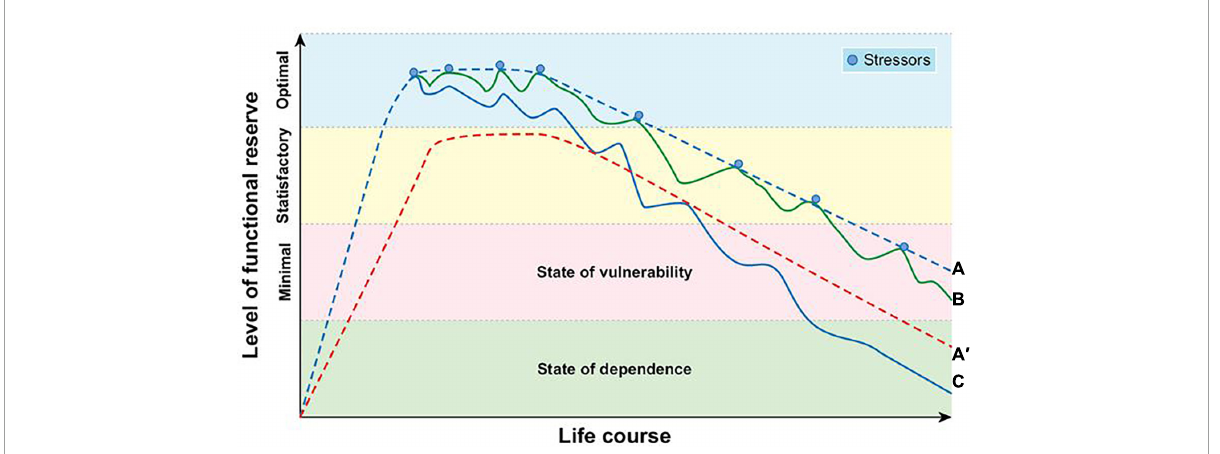
FIGURE1 Schematic representation of life-course trajectories of functional reserve and vulnerability to stressors. (A) Normal development and decline of functional reserve. (A (cid:48) ) Reduced functional reserve due to suboptimal development at early life. (B) Trajectories of adaptive response to stressors. (C) Trajectories of maladaptive response to stressors.